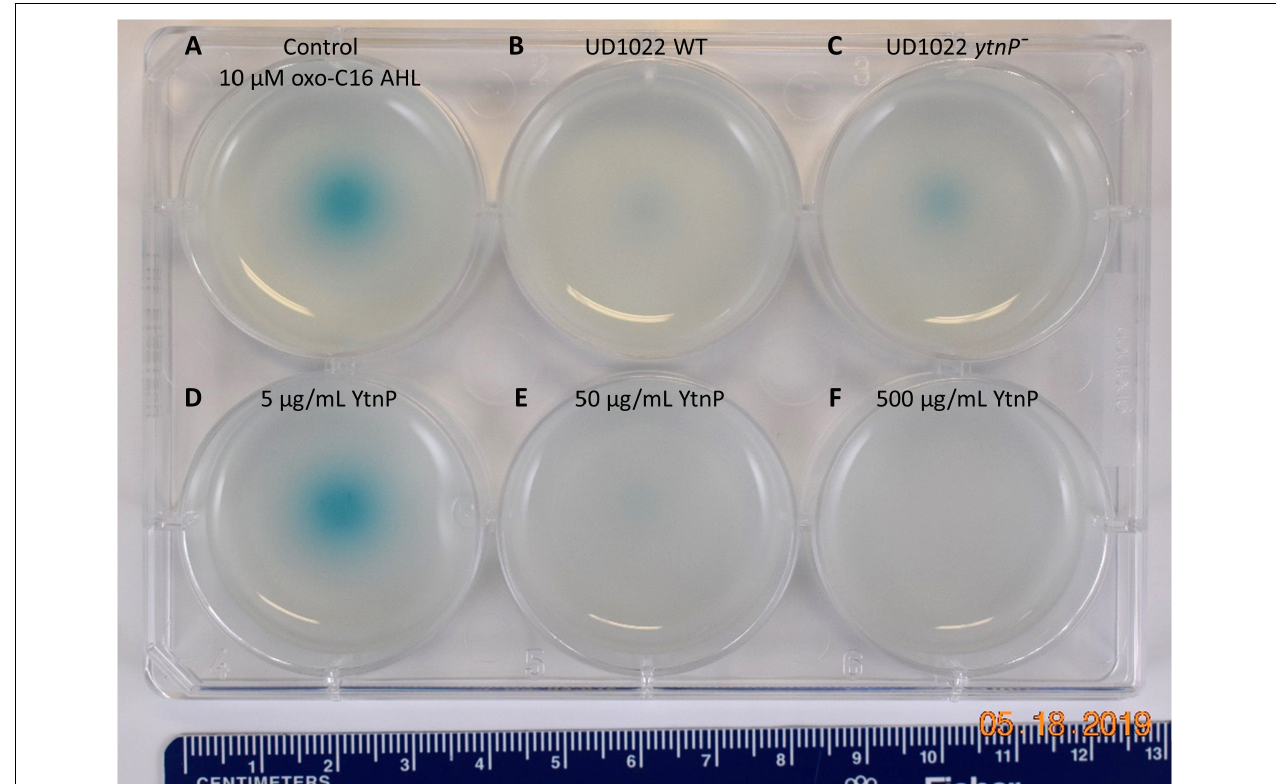
FIGURE 5 | UD1022 quorum quenching biosensor assay plate. The biosensor KYC55-X-gal soft agar plate treated with UD1022-AHL co-cultures. From top left across (A) control treatments of standard AHLs with no UD1022. (B) QQ activity of UD1022 culture with 3-oxo-C16-AHL (C) UD1022 ytnP − mutant cultured with